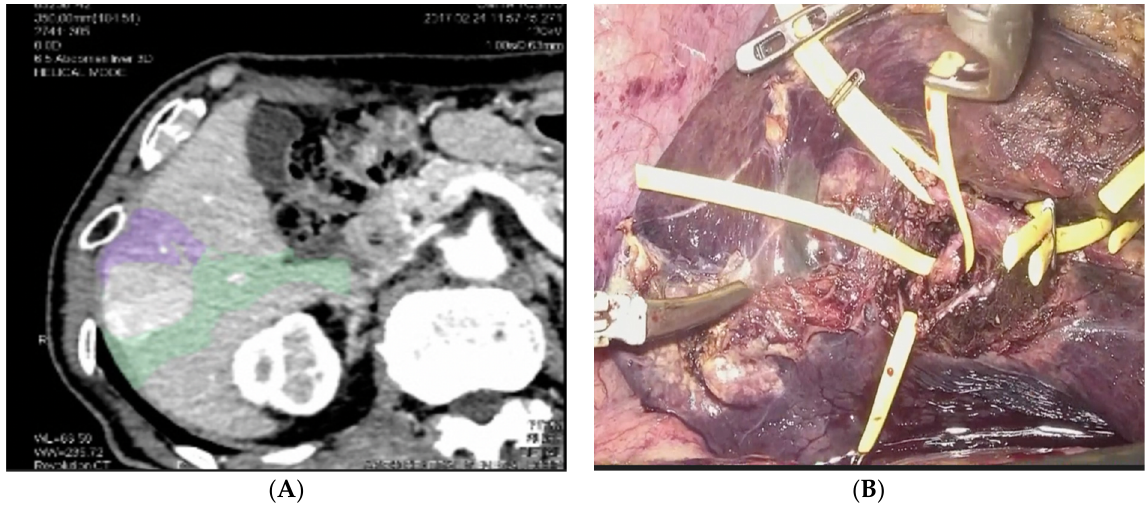
Figure 3. Anatomical Parenchymal Sparing Liver Resections: ( A ) 3D reconstruction with tumor bearing area from pedicles of segment 5 and segment 6. ( B ) Intraoperative view of the isolation of the Glissonian pedicles for segment 5 and 6.